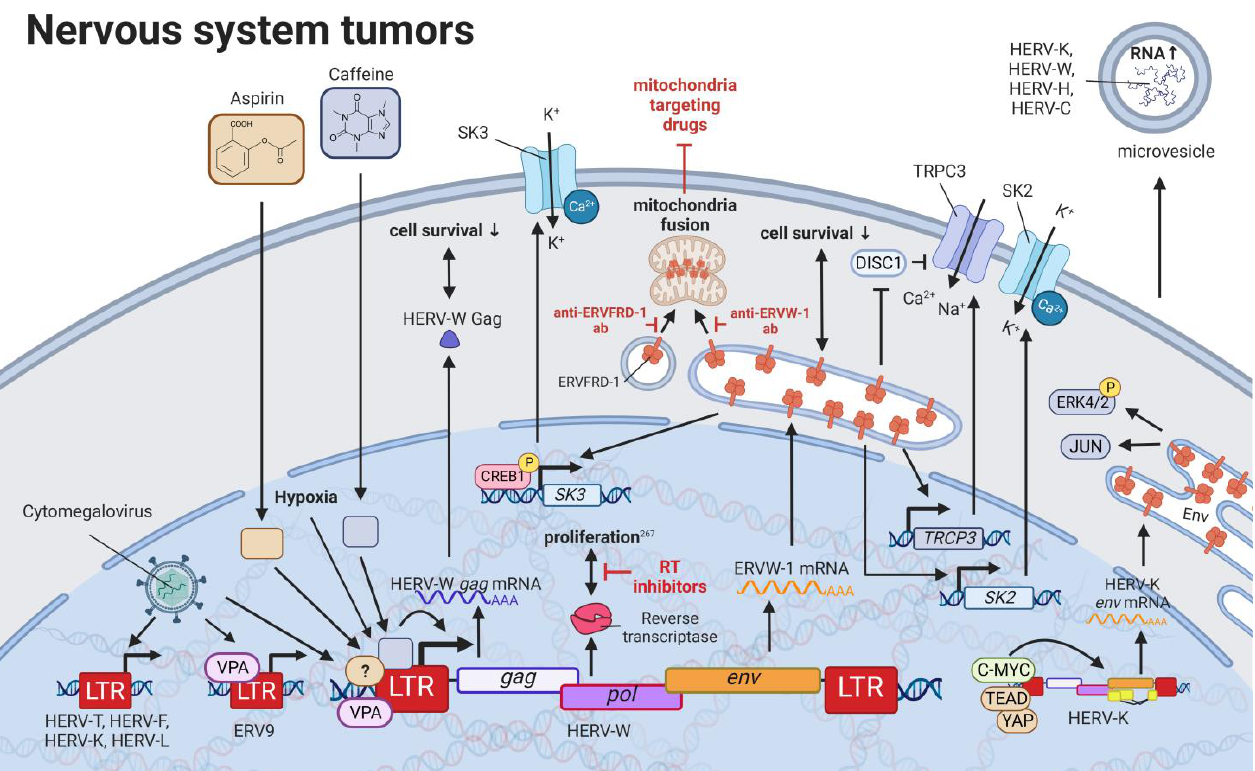
Figure 8. The role of HERVs in nervous system tumors. Evaluated treatments are marked in red. Abbreviations: K + = potassium, Ca 2+ = calcium, ab = antibody, LTR = long terminal repeat, gag = group antigen (capsid), pol = polymerase, RT = reverse transcriptase, env = envelope, HERV-K = HML-2.